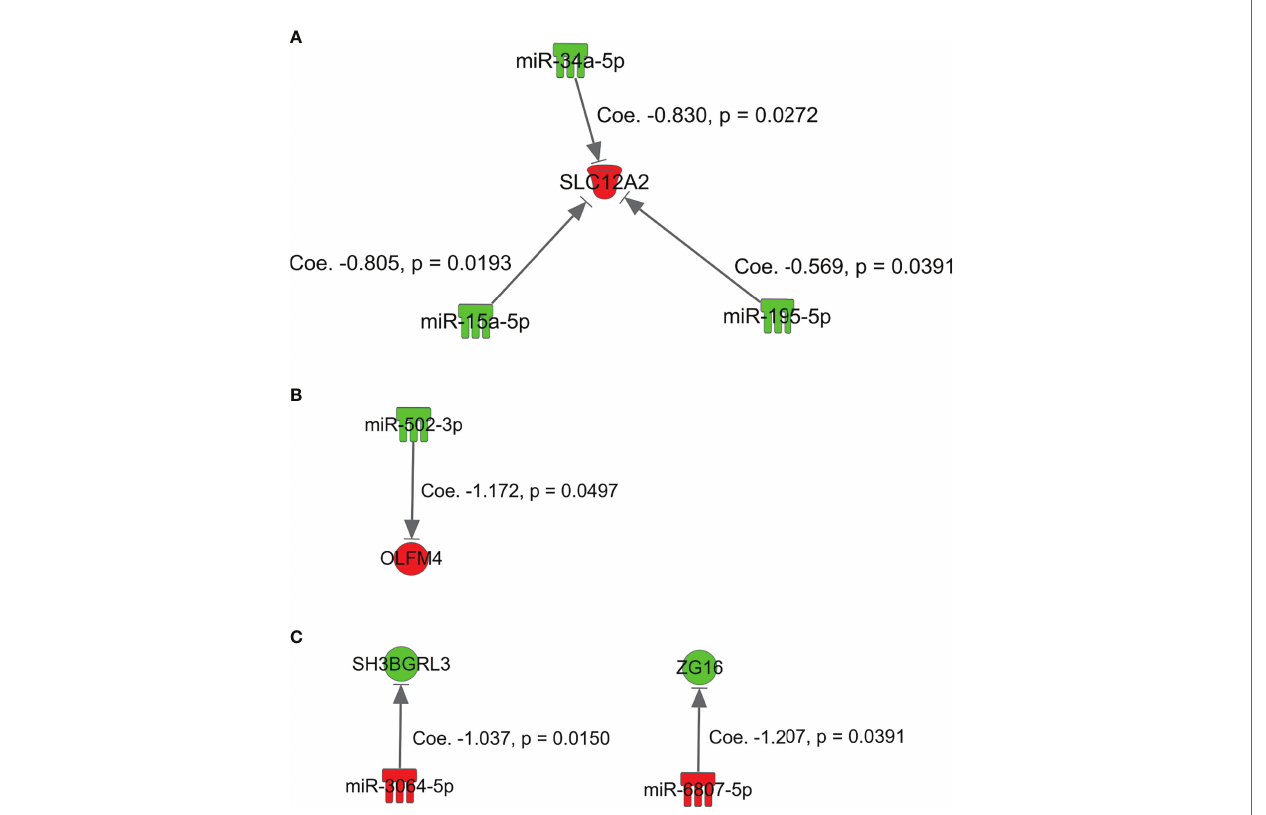
FIGURE 3 | miRNAs and mRNAs with inverse expression patterns in array-based assays in the fi rst cohort of adenoma, intramucosal cancer, and CRC with MSS. (A) , SKC12A2/miRNA-15a-5p, miRNA-34a-5p , and miRNA-195-5p in adenoma. (B) GSKIP/miRNA-664b-3p and OLFM4/miRNA-502-3p in IMC. (C)